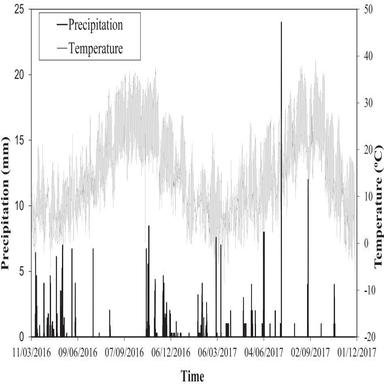
Evolution of the precipitation and temperatures during the period in which the system was monitored.